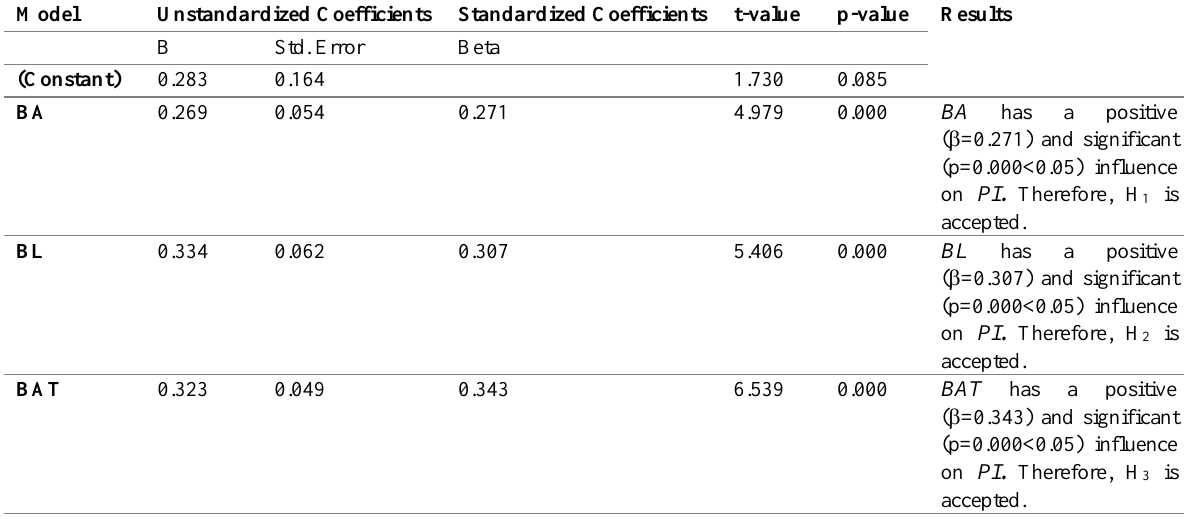
Table 7: Regression